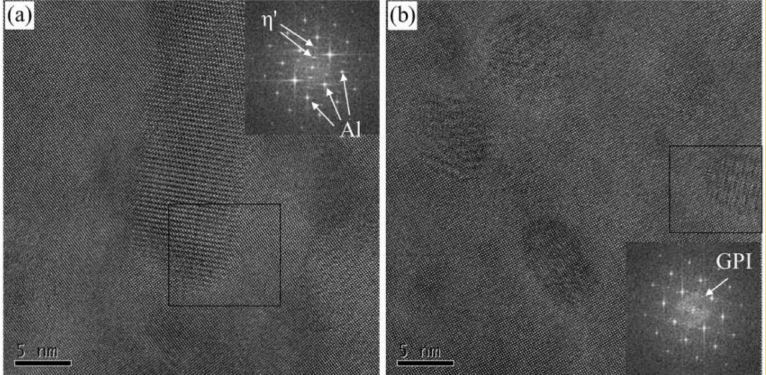
Figure 5. HRTEM images and corresponding SAED patterns for peak-aged alloy. ( a ) η ’ phase; ( b ) GPI